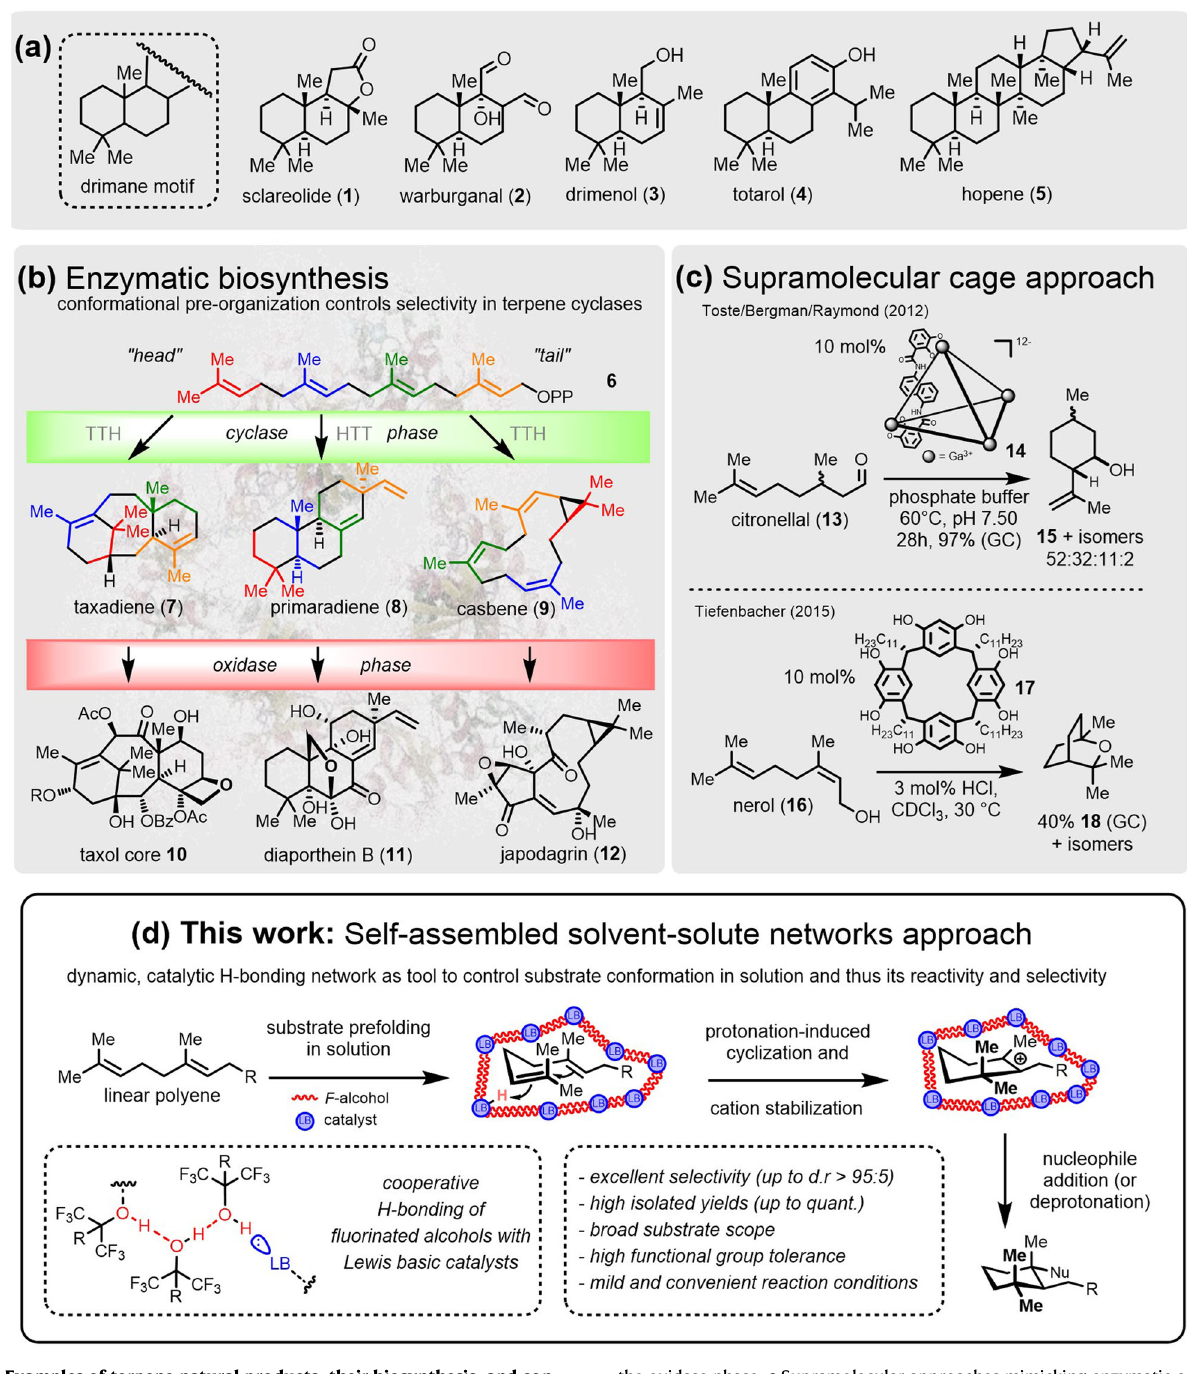
the oxidase phase. c Supramolecular approaches mimicking enzymatic con fi ne- mentbyemployingmacromolecularcagesforselectivecyclizations 44,45 . d Concept formacromolecularsolventclustersfacilitatingeffective cyclizationsthroughpre- arrangement of the apolar polyene chain in the dipolar solvent